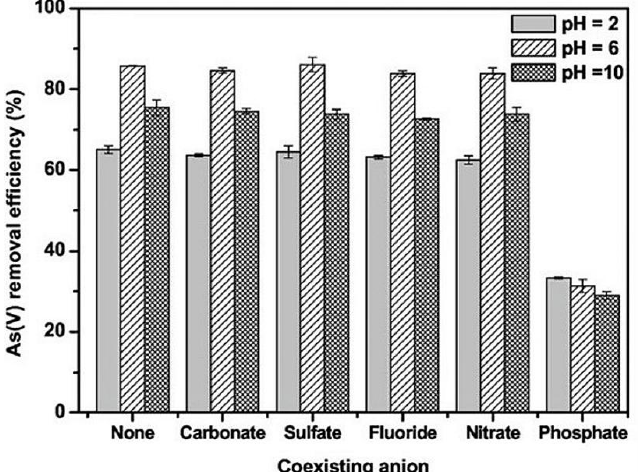
Figure 22. The effect of co-existing anions on the adsorption of As (20% FBC) [94]. Reprinted with permission from Ruozhu He et al. (2017). Copyright 2017, Elsevier.